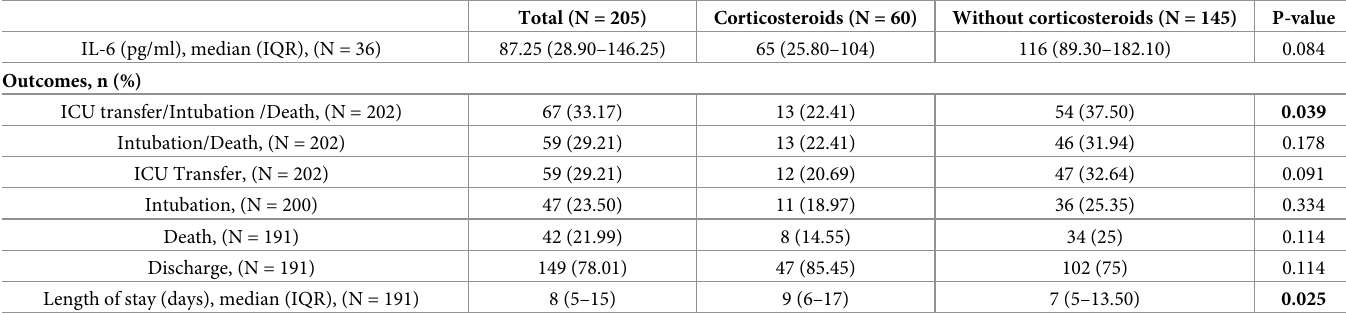
duration of 5 days (IQR, 4–7) (Table 1)